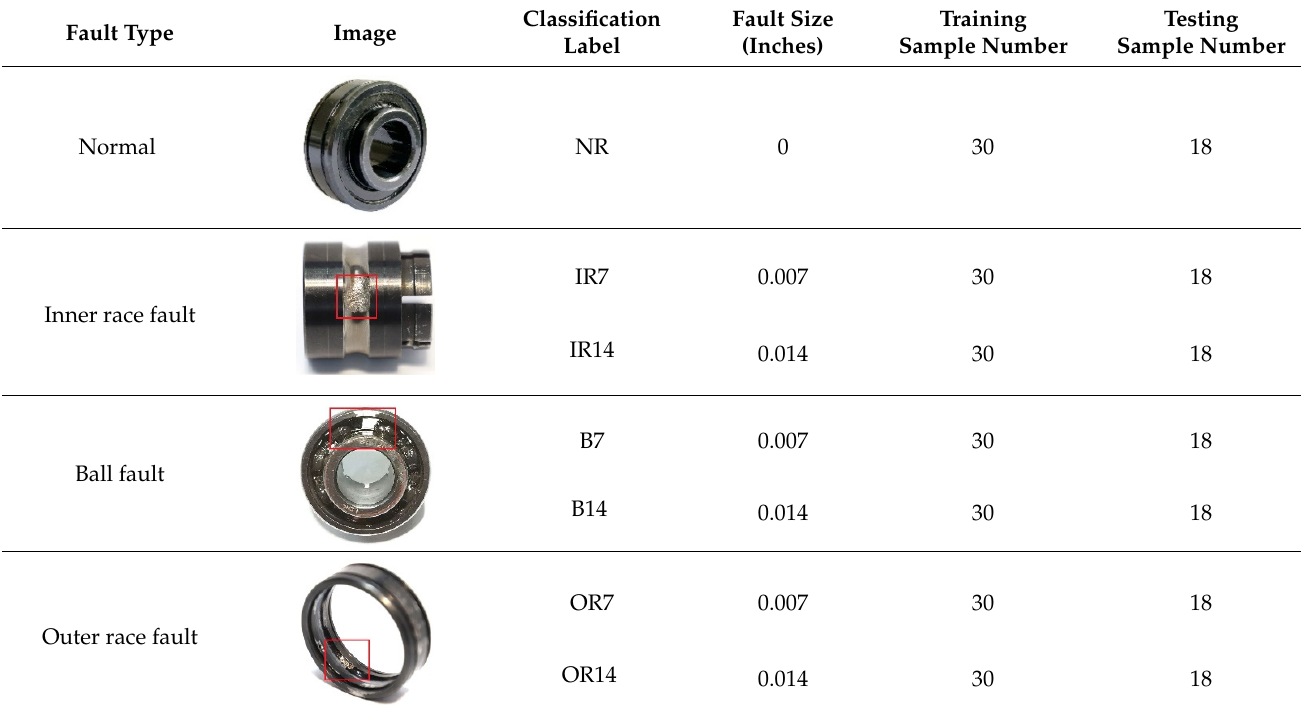
Table 1. Details of the experimental data.